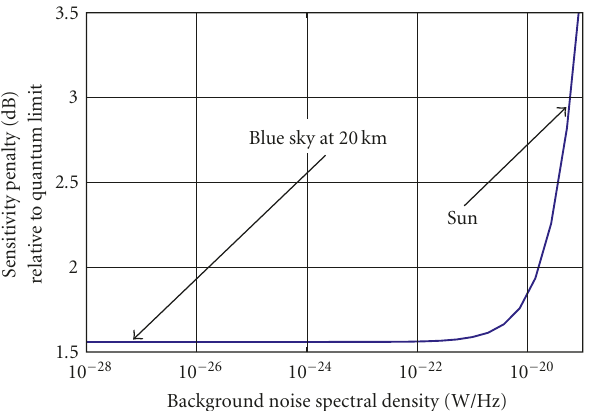
Figure 2: Calculated receiver sensitivity penalty of an optically preamplified receiver using RZ intensity modulation at a bit error probability of 10 − 9 as a function of background noise power spec- tral